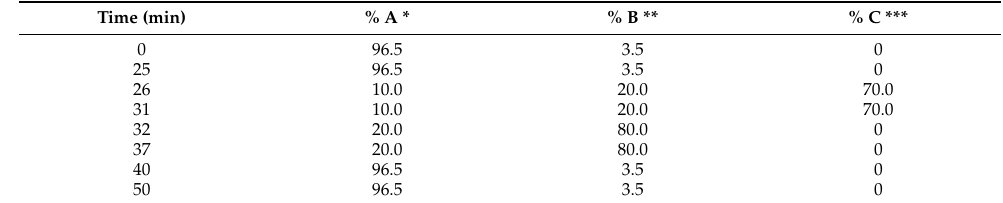
Table A2. The gradient used in CarboPac PA1 column for qualitative and quantitative analysis of simple carbohydrates. Time (min) % A